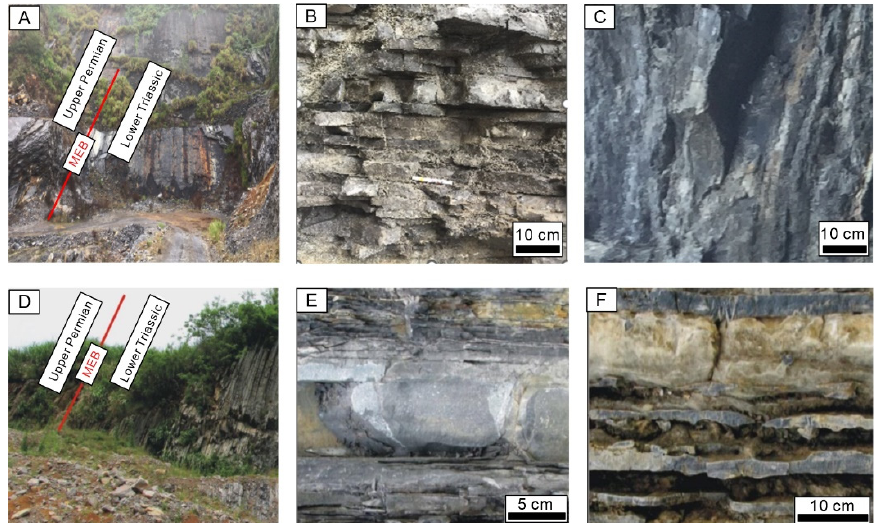
Figure 2. outcrop pictures of Chibi North and Chibi West sections. ( A ) outcrop picture of Chibi North section, ( B ) argillaceous limestone at the bottom of the Early Triassic Daye Formation, Chibi North section, ( C ) siliceous limestone in the top of the Late Permian Dalong Formation, Chibi North secion, ( D ) outcrop picture of Chibi West section, ( E ) black argillaceous limestone at the bottom of the Early Triassic Daye Formation, Chibi West section, ( F ) Limestone at the top of the Late Permian Dalong Formation, Chibi West section.